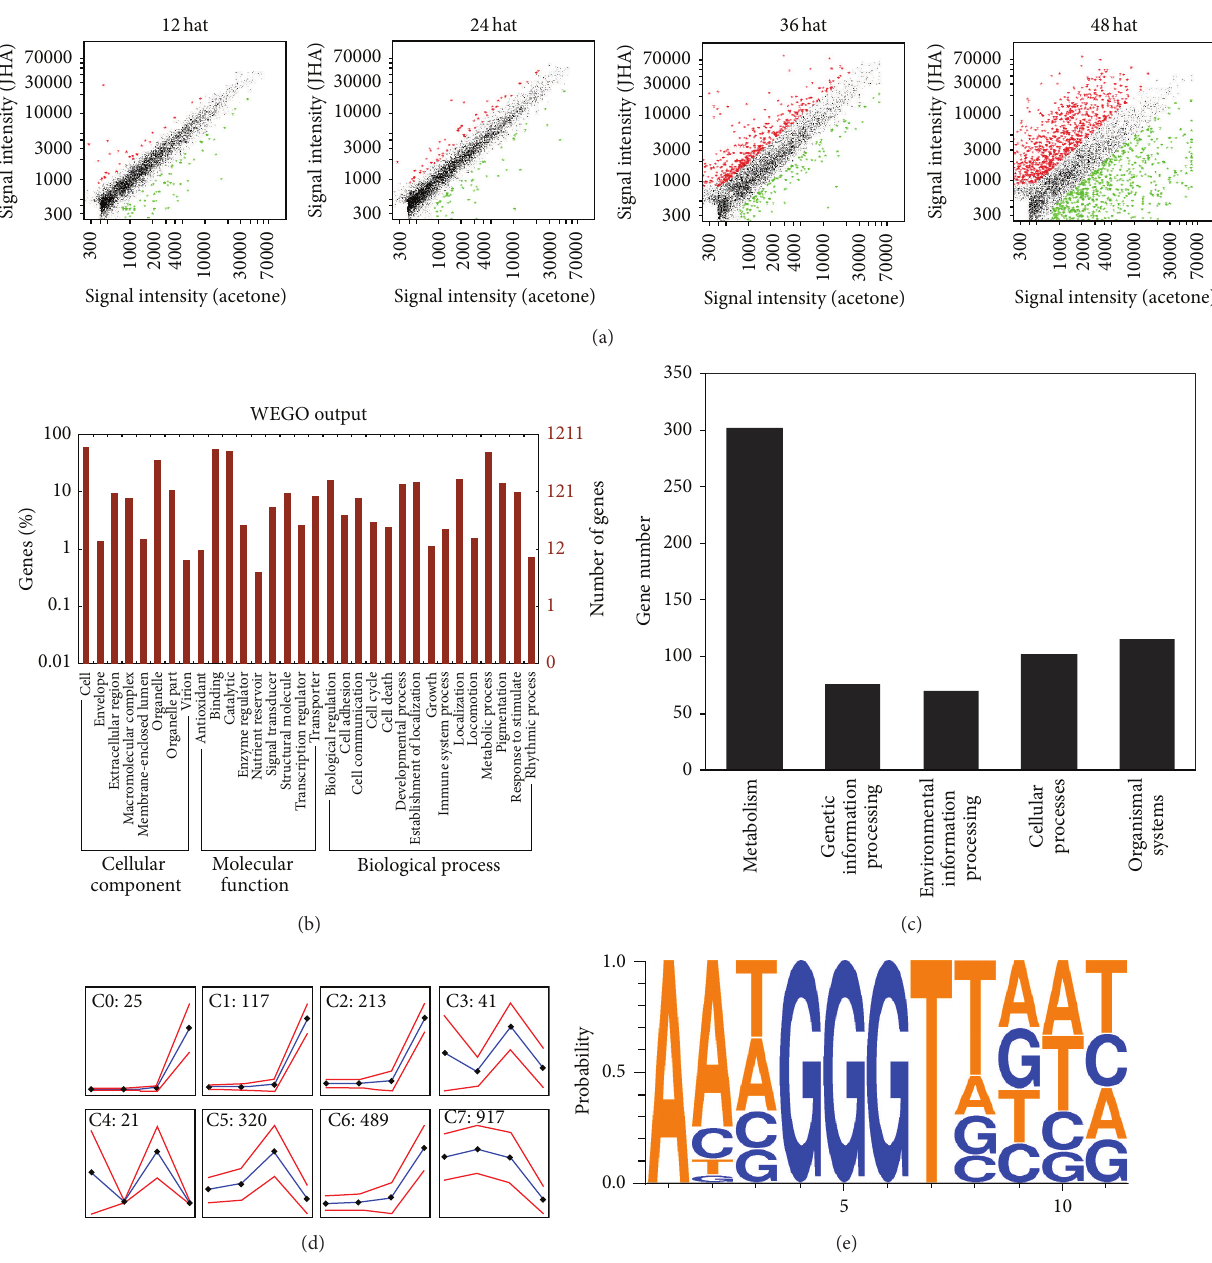
Figure 2: Genomewide alteration of gene expression after JHA application. Genomewide microarray analysis revealed that gene expressions in the integument and fat body were altered after JHA application. (a) Scatter plot of genomewide changes in gene expression. Hat: hours after treatment. (b) Gene ontology (GO) annotation of JHA-modulated genes with an at least 2.0-fold change in expression level after JHA application. All JHA-modulated genes are listed in Table S3 available online at http://dx.doi.org/10.1155/2014/426025. (c) JHA-modulated genes can be functionally classified into different KEGG pathways. For details see Tables S5 and S8. (d) Time course-dependant coexpression of JHA-modulated genes after JHA application in the integument. The digits denote the number of JHA-modulated genes in each cluster. The JHA-modulated genes in each cluster are listed in Table S6. (e) Multiple alignments of conserved binding motifs of Kr-h1 within the upstream UTR regions of JHA-induced